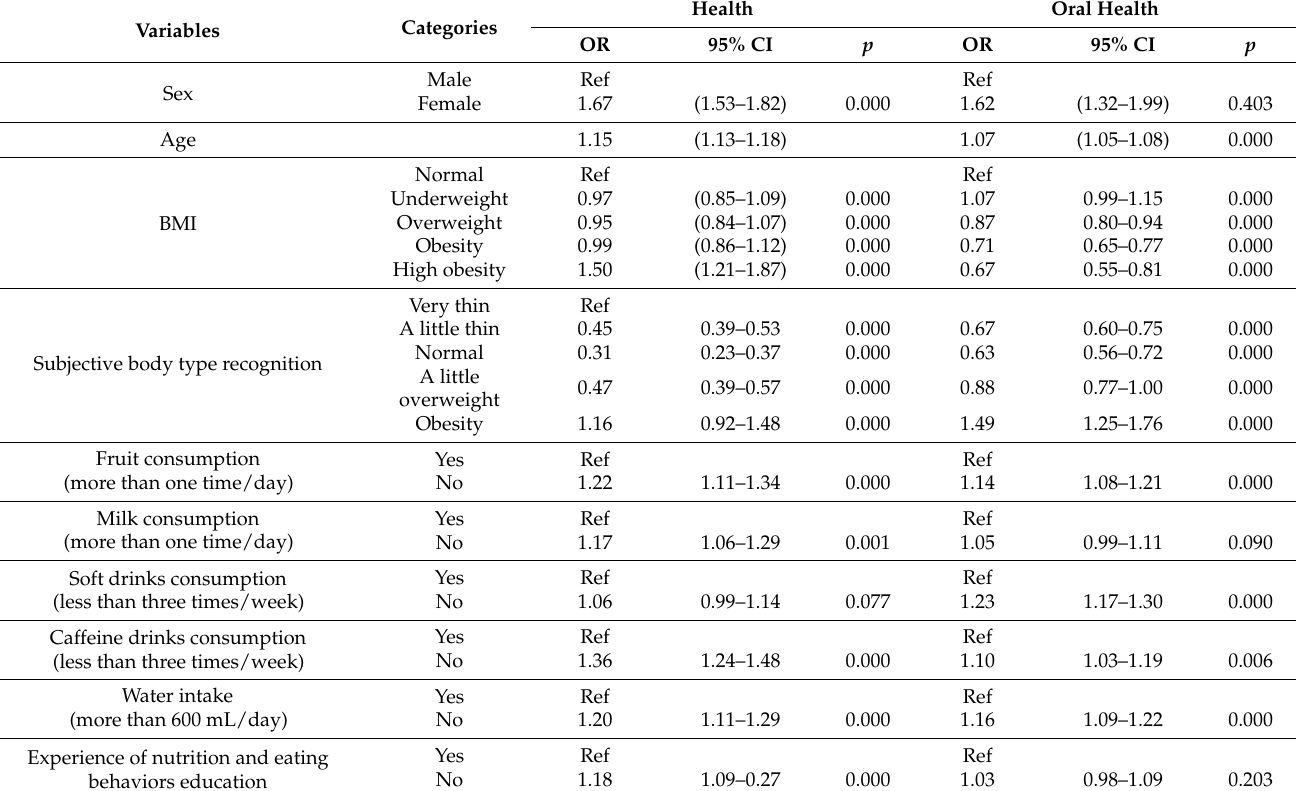
Table 6. Factors related to the association between body type recognition, eating behavior, oral health behavior and symptoms, eating disorder, and subjective health and oral